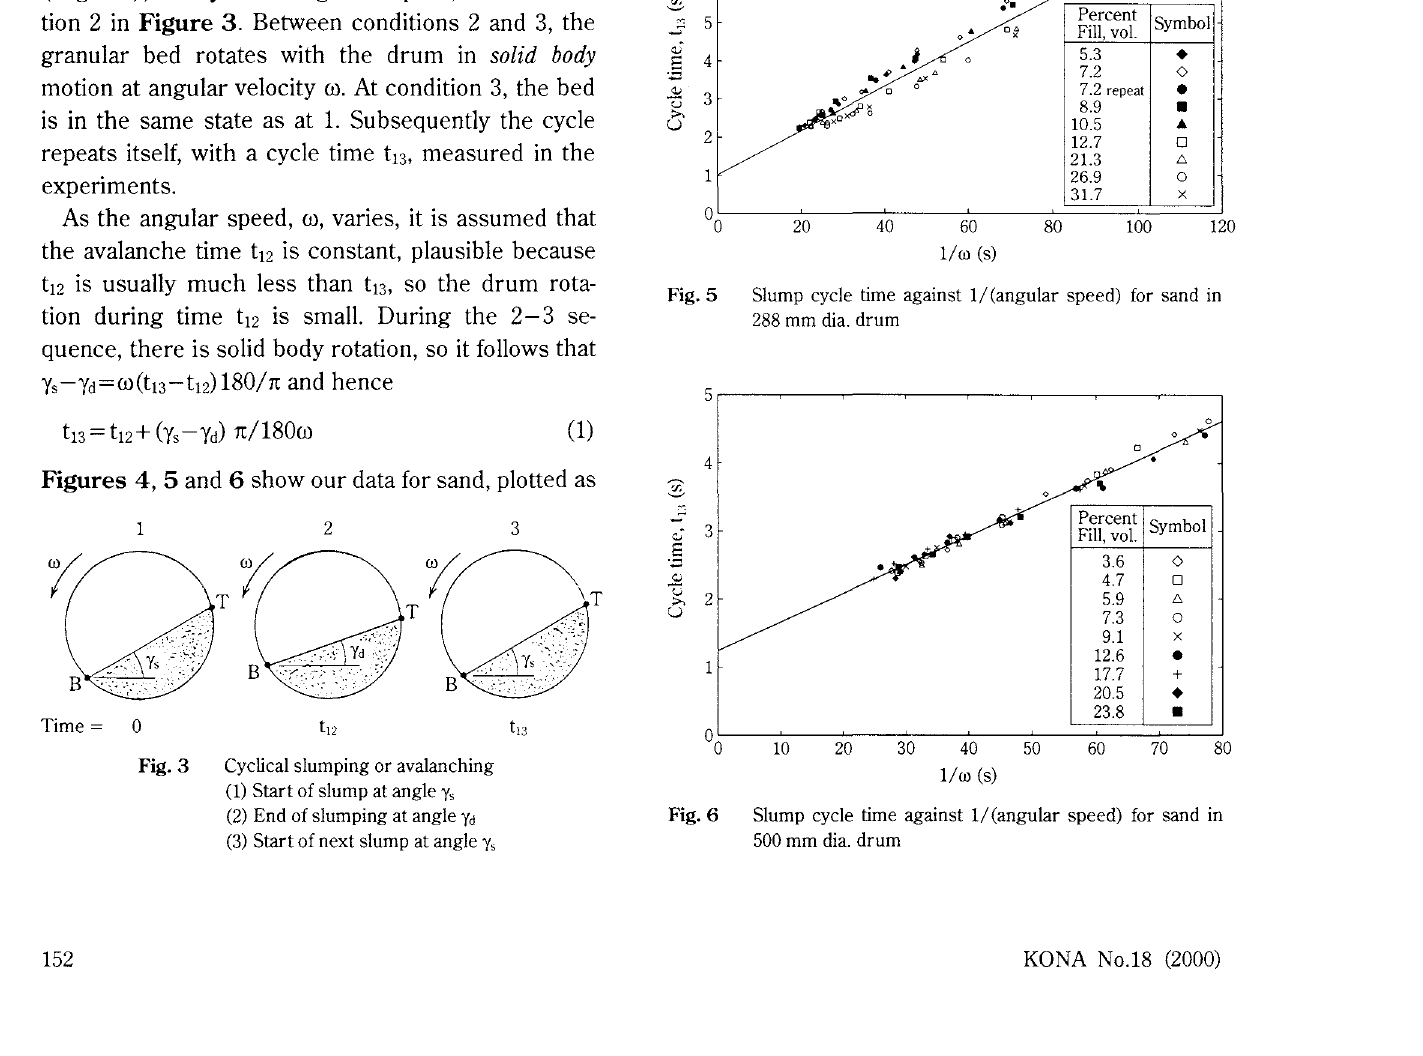
Percent Fill, vol. Symbol